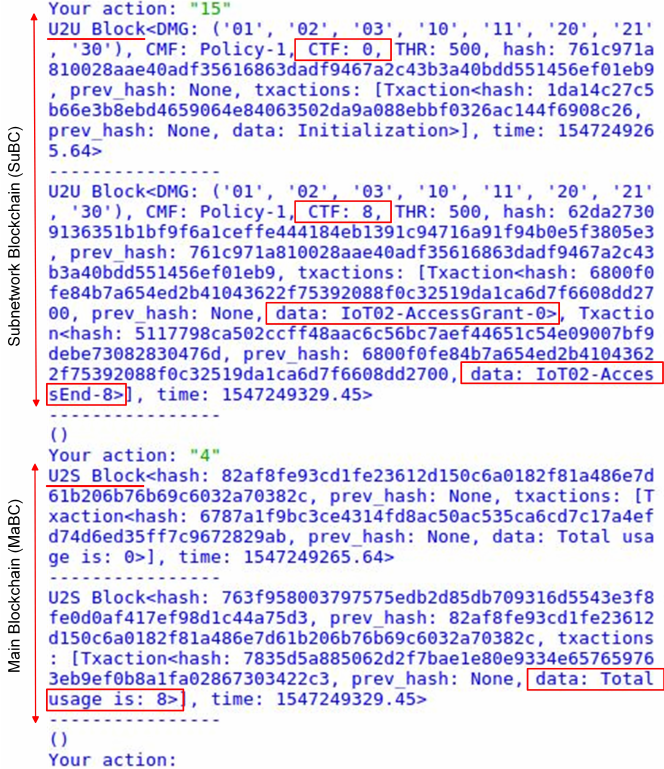
Figure 7. Energy usage transactions in SuBC and